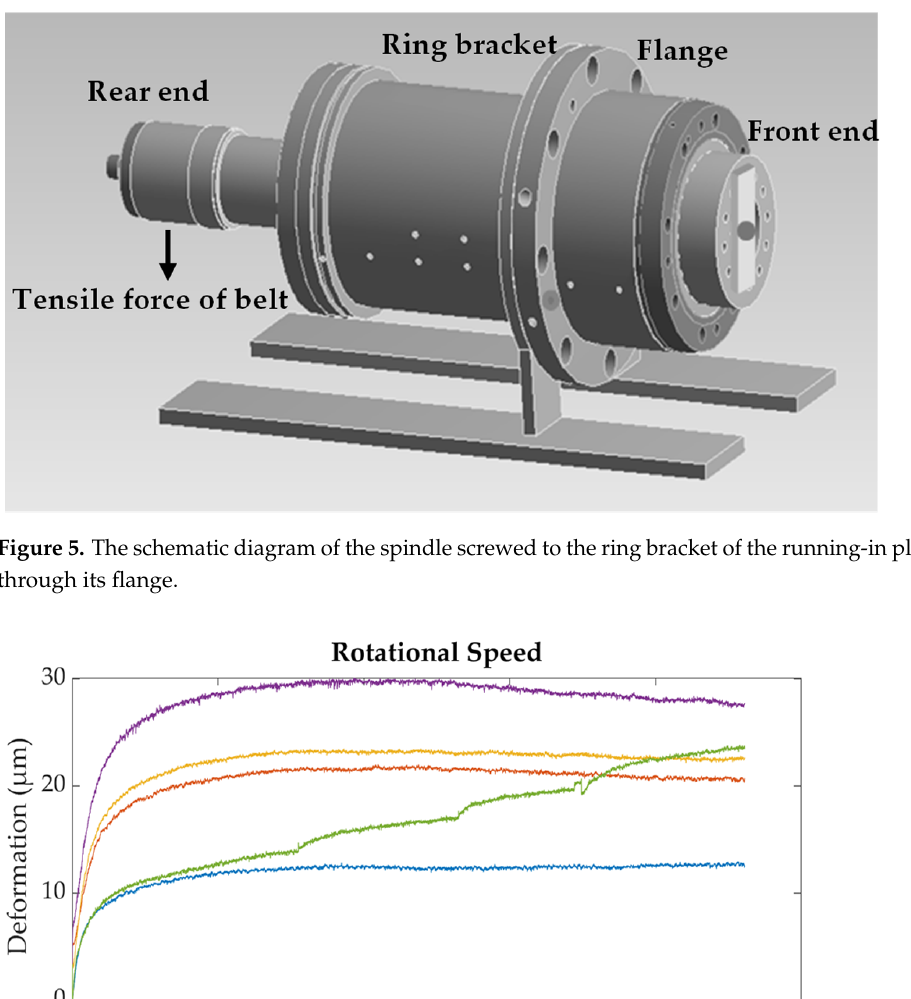
Figure 4. The demonstration of the feature temperatures measurement results under variable speed: 5000 → 6000 → 7000 → 8000 rpm.